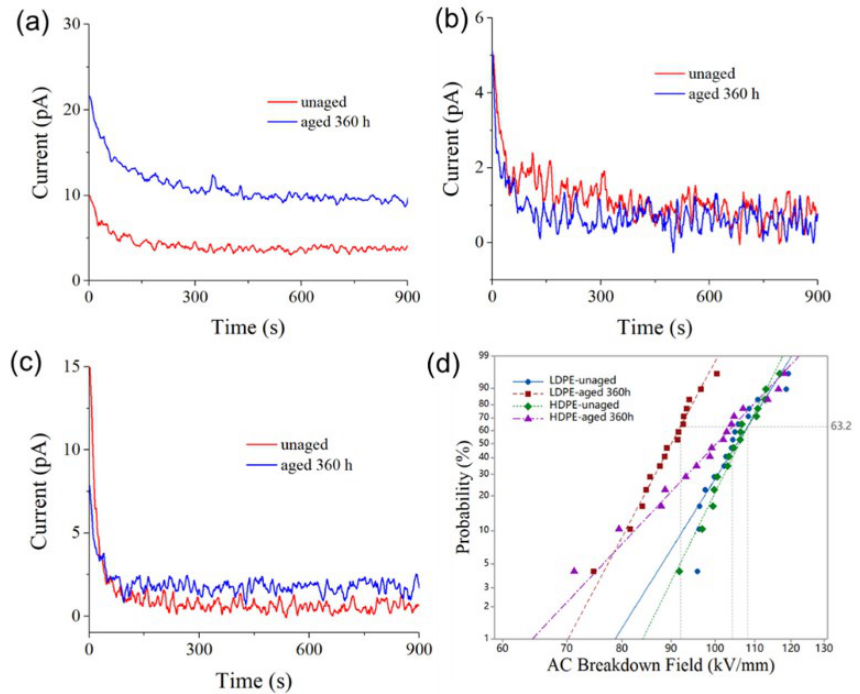
Figure 12. Conduction current of ( a ) LDPE, ( b ) FPE, and ( c ) HDPE under 10 kV/mm. ( d ) Weibull plots of AC BDS.